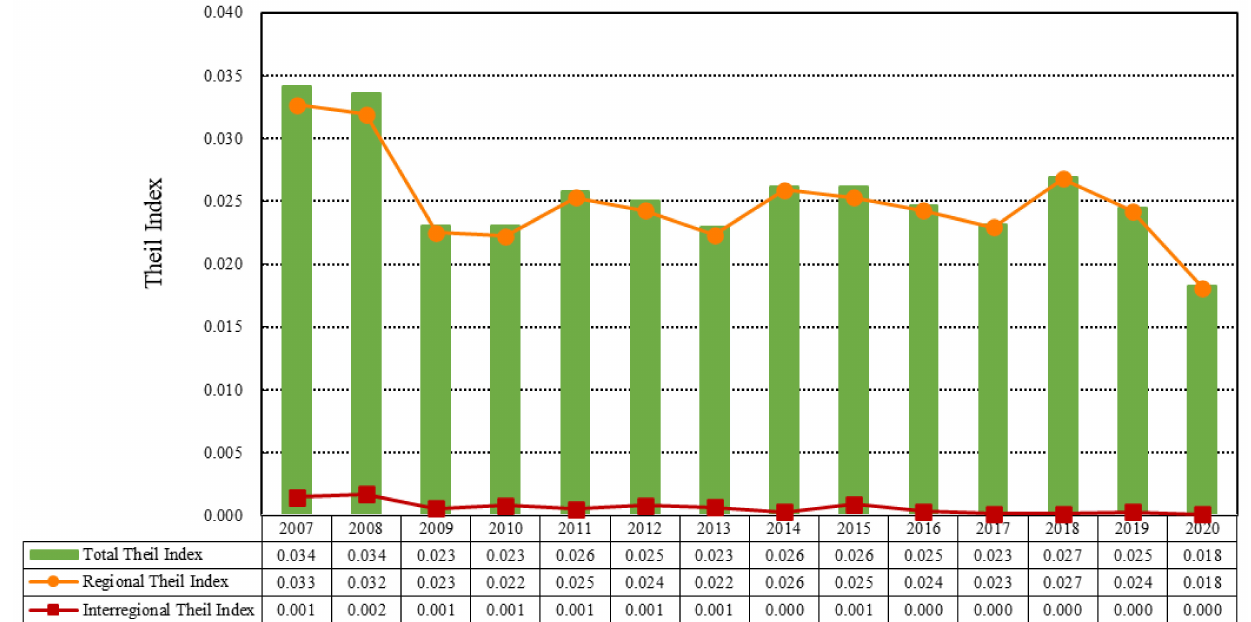
Figure 6. Theil index of cities’ EWP in China from 2007 to